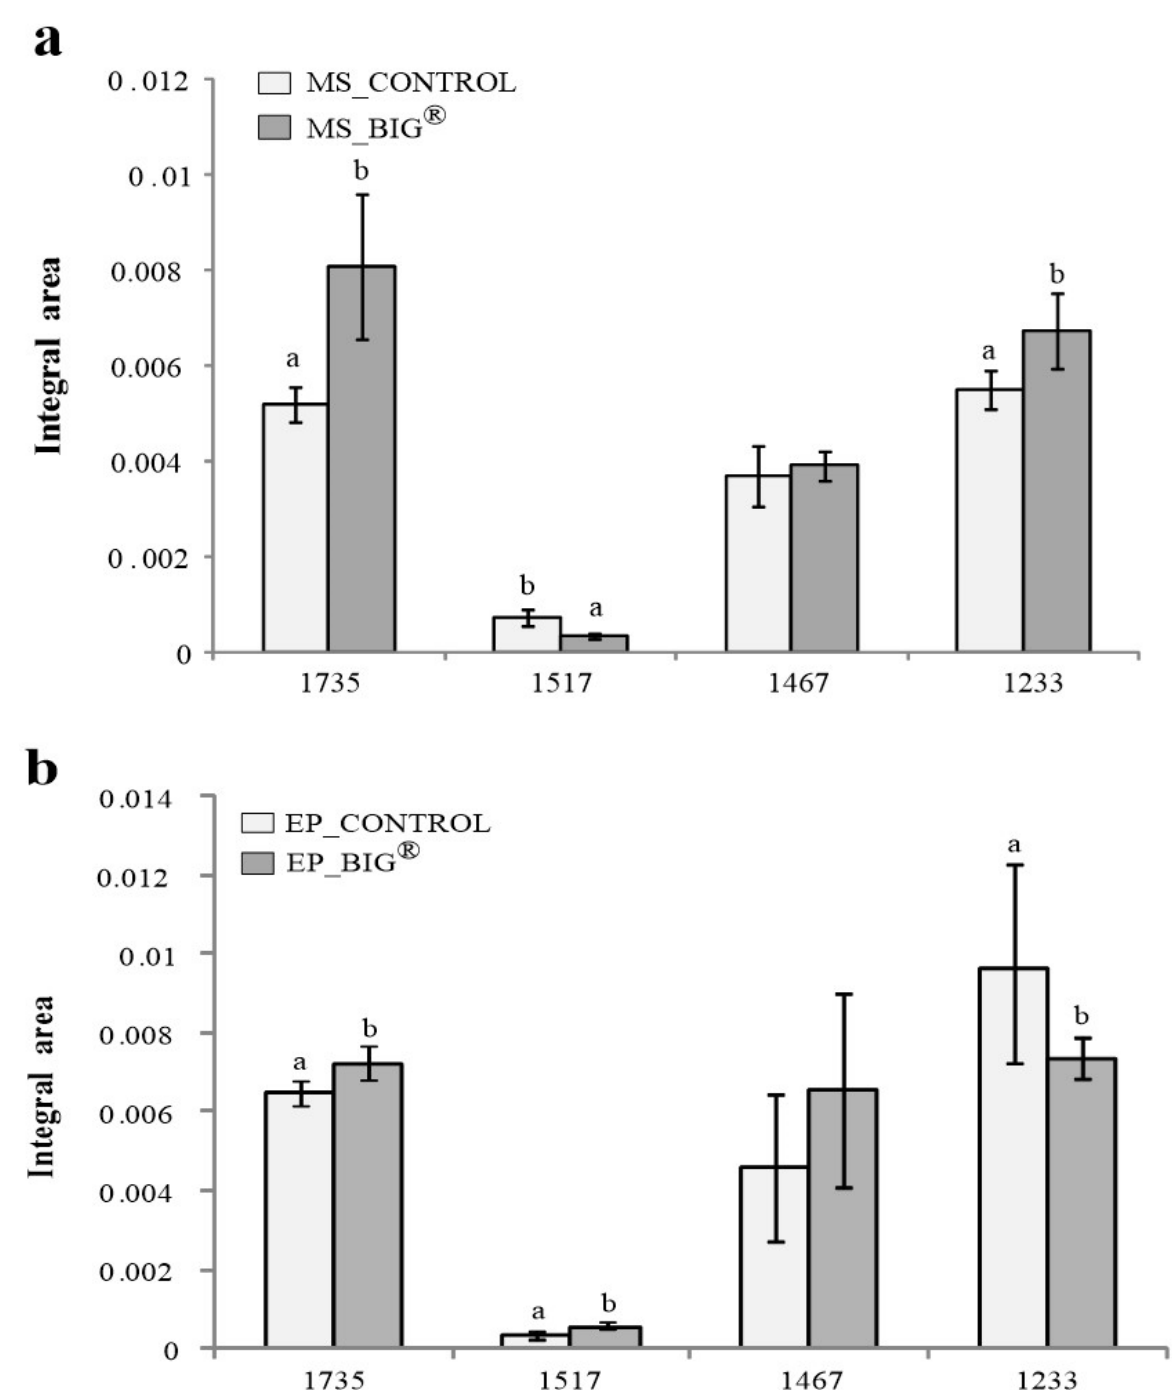
Figure 9. Integral areas of absorbance between 1750 and 900 cm − 1 of the mesophyll ( a ) and epidermis ( b ) of rice leaves of cv. KDML 105 in an inoculation challenge with Xoo at 14 DAI under greenhouse conditions ( ρ < 0.05). ( a ) Mesophyll integral areas of rice plants after inoculation challenge with BIG ® compared with the control. ( b ) Epidermis integral areas of rice plants after inoculation challenge with BIG ® compared with the control.